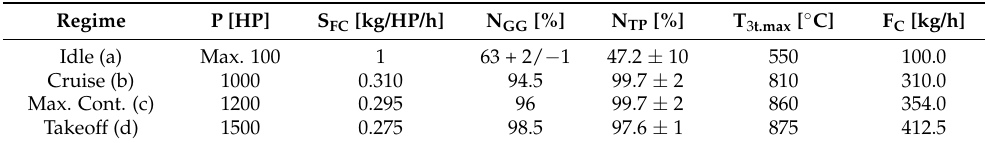
Table 1. TV2-117A operating